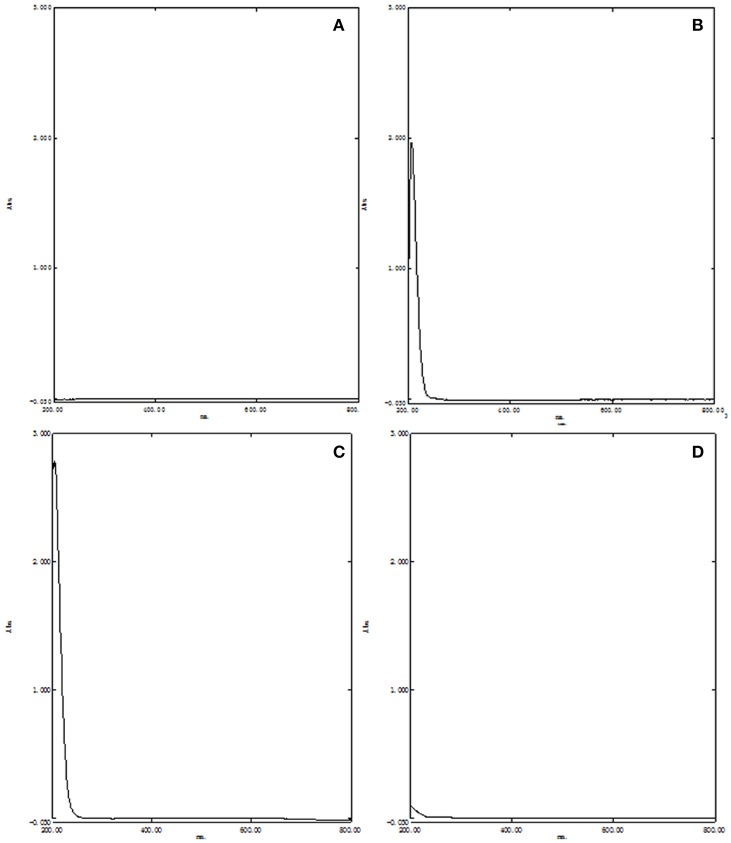
UV–vis absorption spectra of (A) HPβCD, (B) BCP, (C) physical mixture, and (D) HPβCD/BCP. No absorption peak is observed in HPβCD. The spectra of BCP and the physical mixture were identical, and both achieved a maximum absorption wavelength of 205 nm. No absorption peak was found in the spectrum of the HPβCD/BCP.